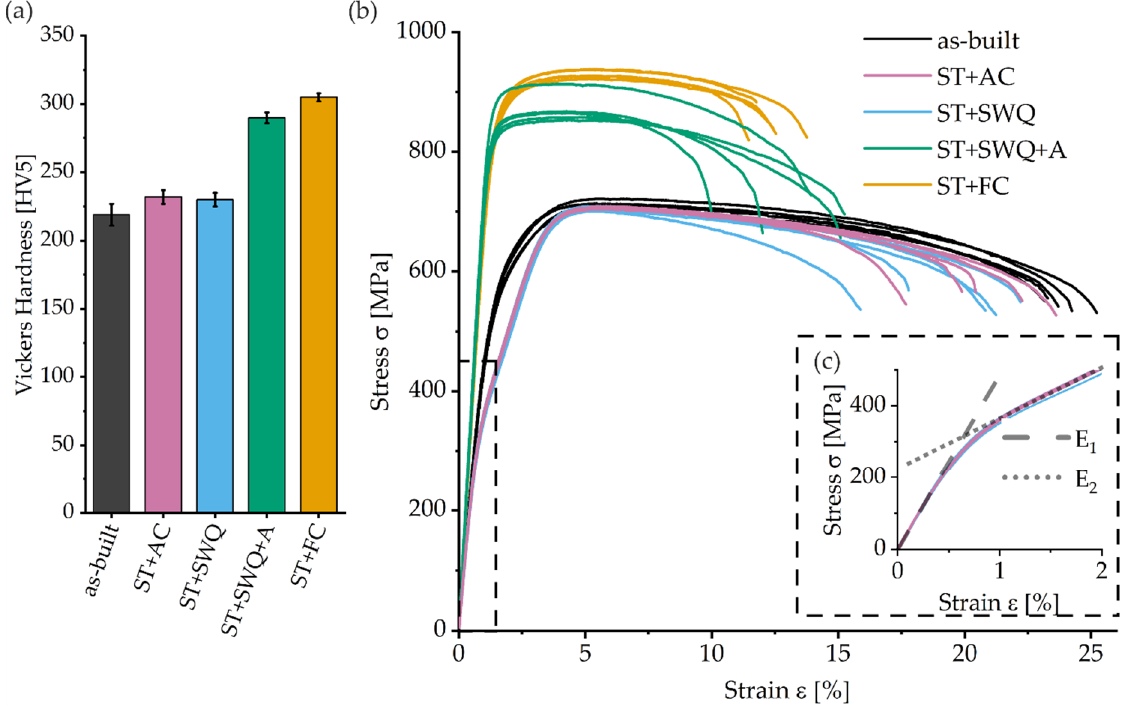
Figure 8. ( a ) Vickers hardness for different conditions; ( b ) stress–strain curves of different conditions; ( c ) inset of the dashed boxed in ( b ) presenting the nonlinear elastic behavior of the ST+AC and ST+SWQ conditions.